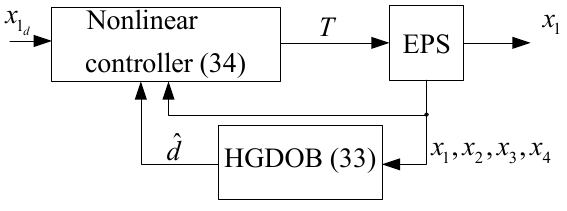
Figure 3. Block diagram of the proposed